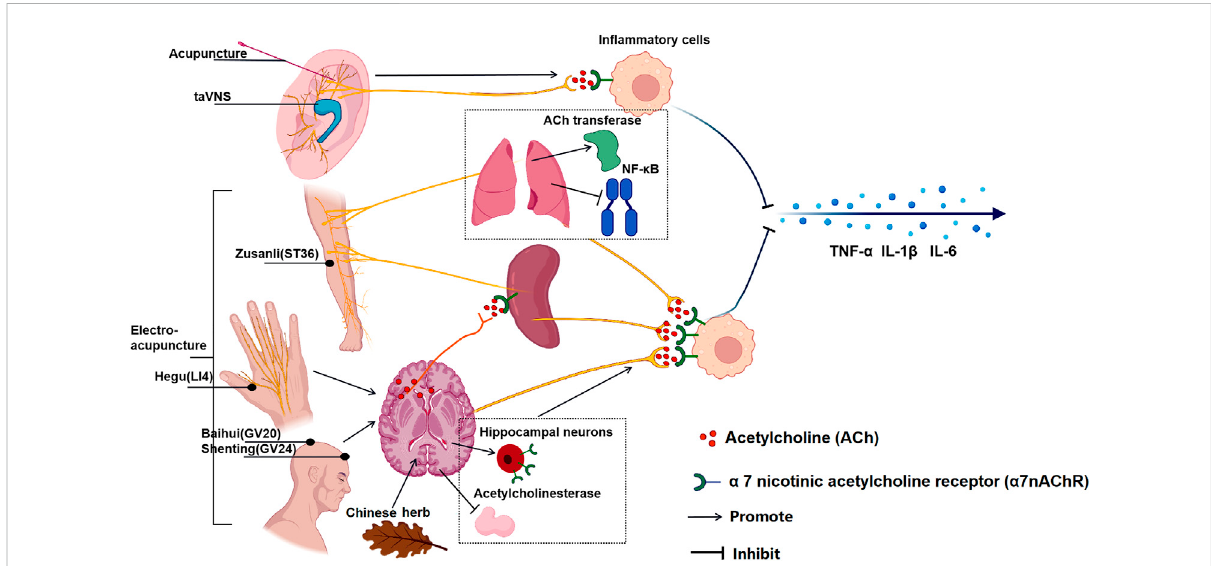
FIGURE 2 The effect of multiple TCT on CAP. Acupuncture and taVNS stimulating in ear branch can activate CAP and the reduce in fl ammatory cytokines; Auricular acupuncture and electroacupuncture “ Zusanli ” (ST36) increased the activity of local acetylcholine transferase, promoted the transcription and synthesis of ACh, inhibiting the expression of NF- κ B in lung tissue and stimulating the CAP in the lung; Moreover, electroacupuncture ST36activatedthevagusnervepathwayconnectedtothespleenandreducedtheproductionofTNFinthespleen;Electroacupuncture “ Hegu ” (LI4) activates muscarinic acetylcholine receptor signals in the brain, and then activates the efferent vagus nerve and splenic nerve to activate CAP; Electroacupuncture at “ Baihui" (GV20) and “ Shenting ” (GV24) increase the expression of α 7nAChR in hippocampal neurons; The chinese medcine Jiao-Tai-Wan reduced the activity of acetylcholinesterase (AChE) and increase the content of ACh. The ultimate effect of TCT is to activate CAP to reduce the production of in fl ammatory factors in effector organs to inhibit in fl